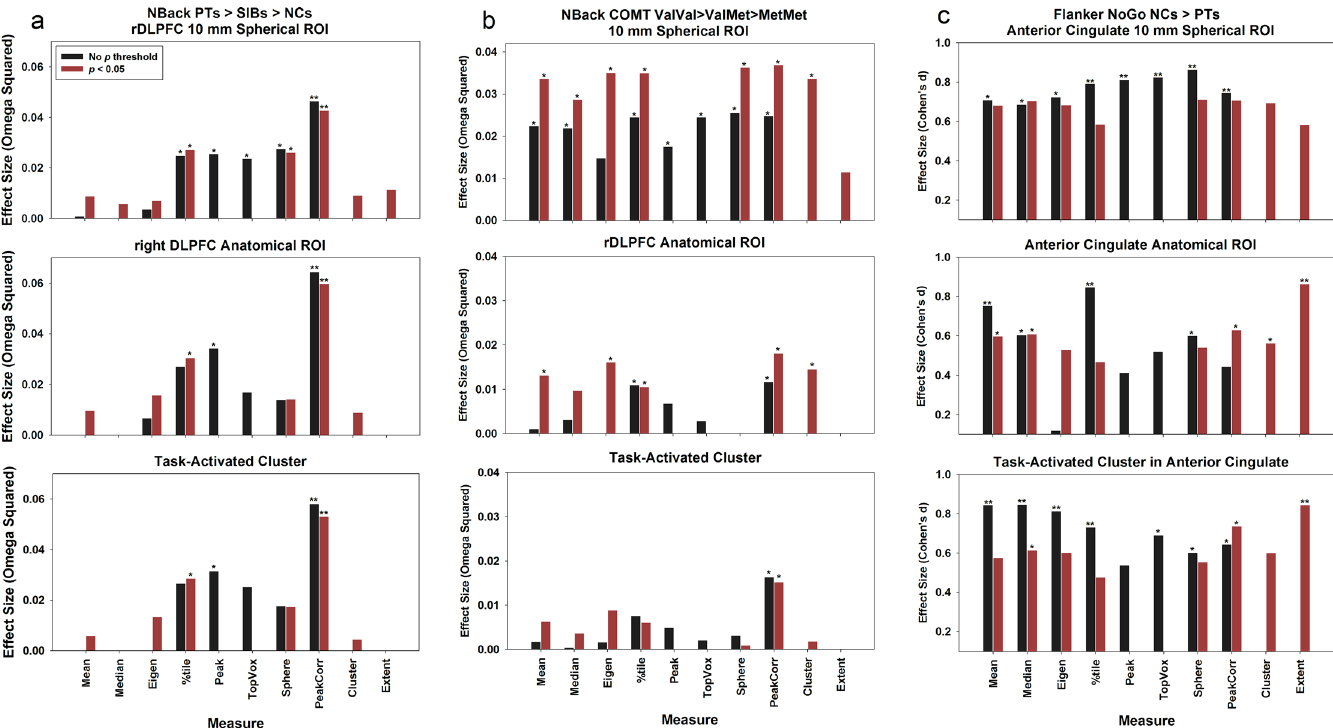
Fig 2. The generalizability of the ROI single value summary measures is further examined across three datasets. (a) The NBack Sibling dataset, PTs vs. SIBs vs. NCs, one-way ANOVA; (b) the NBack COMT dataset, Val/Val vs. Val/Met vs. Met/Met, one-way ANOVA; and (c) the Flanker dataset, NCs vs. PTs, t